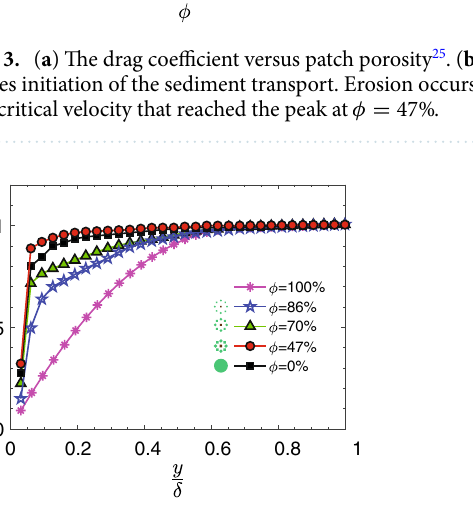
Figure 4. Streamwise velocity profile, U ( x ) at various porosity parameter normalized by boundary layer thickness ( δ ) and upstream velocity ( U ∞